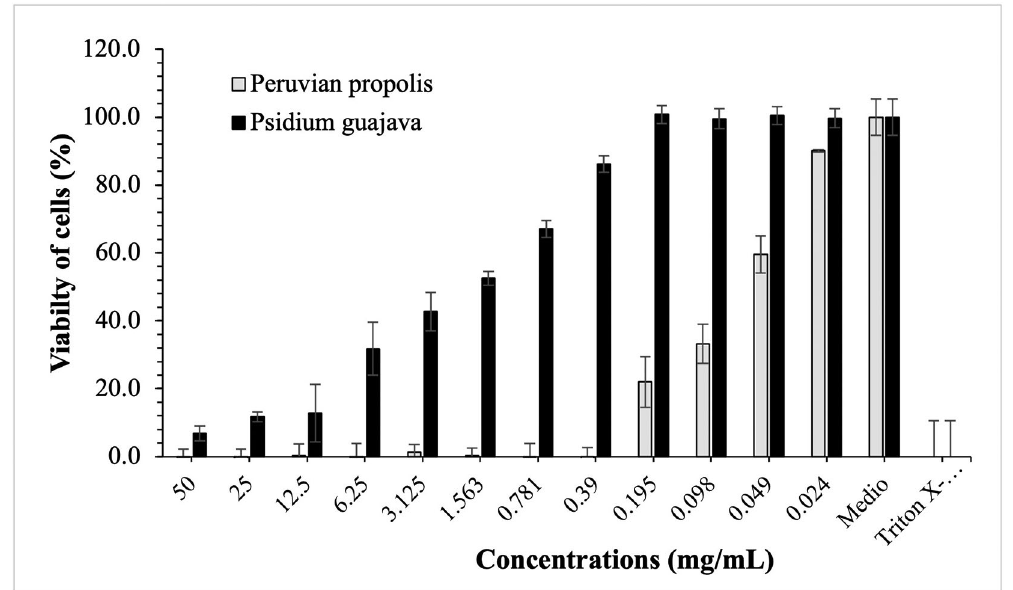
Figure 5. Viability of peripheral blood mononuclear cells (PBMCs) by effect of concentrations of ethanolic extracts of propolis and P. guajava. The growth of peripheral blood mononuclear cells (PBMCs cells) remains in control with propolis doses of 50-0.39 mg/mL, with rapid growth at lower doses; on the contrary, with guajava, althoughatadoseof50mg/mLcellgrowthwassmall,itbeginstoincreaseconsiderablyuptodosesof0.195mg/mL, at which it reaches maximum